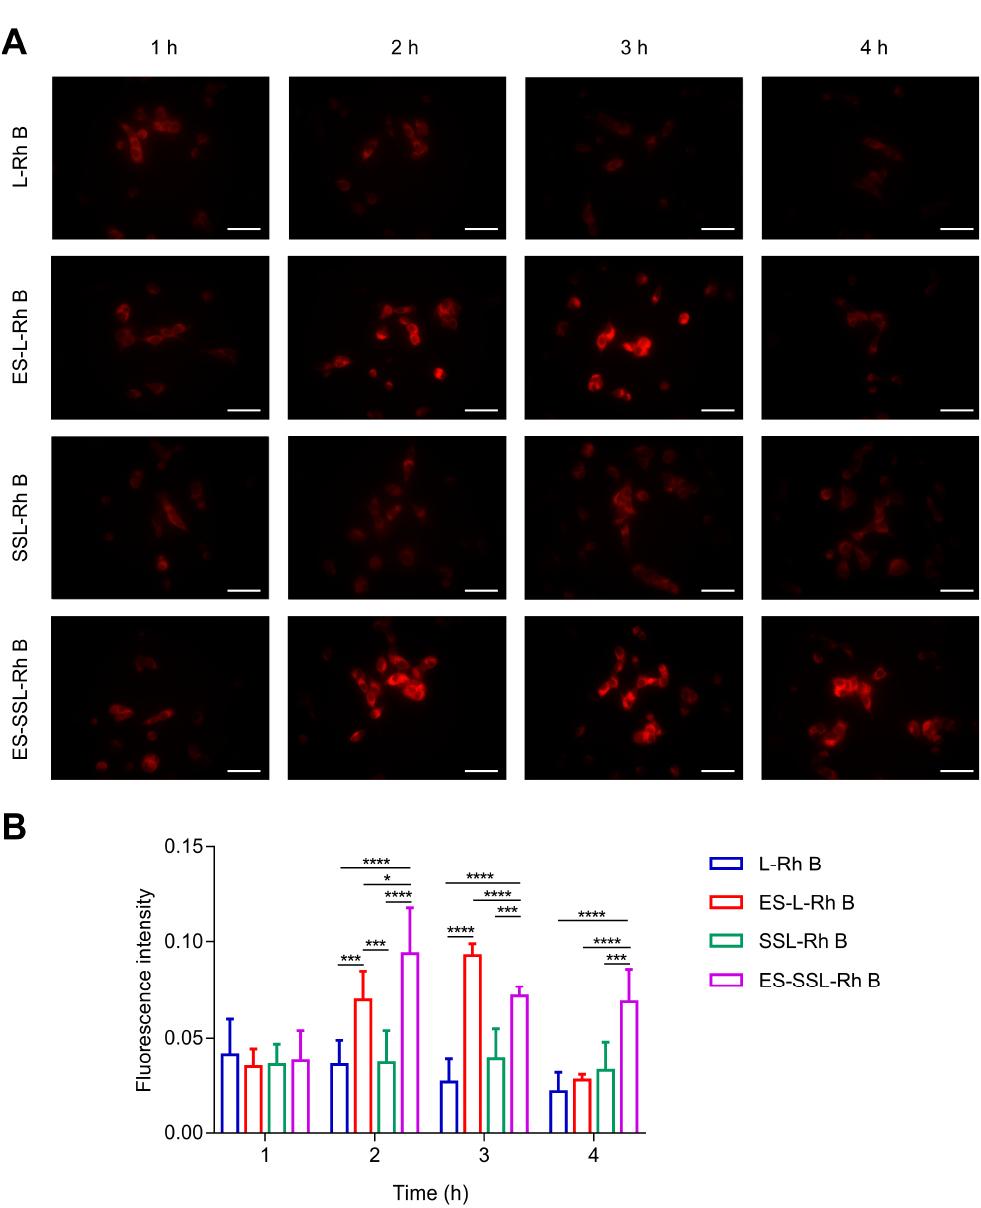
Figure 6. In vitro cellular uptake study. ( A ) Cellular uptake of Rh B-loaded liposomes in A549 cells determined using fluorescence microscopy. Scale bar: 50 µ m. Original magnification: × 200. ( B ) Quantitative analysis of fluorescence intensity using Image J, * p < 0.05, *** p < 0.001, **** p < 0.0001.